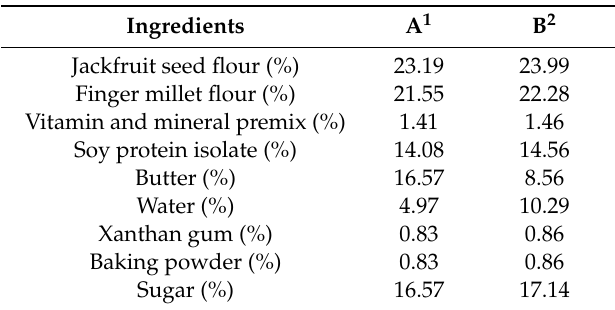
Table 1. Formulation of dough considered in this